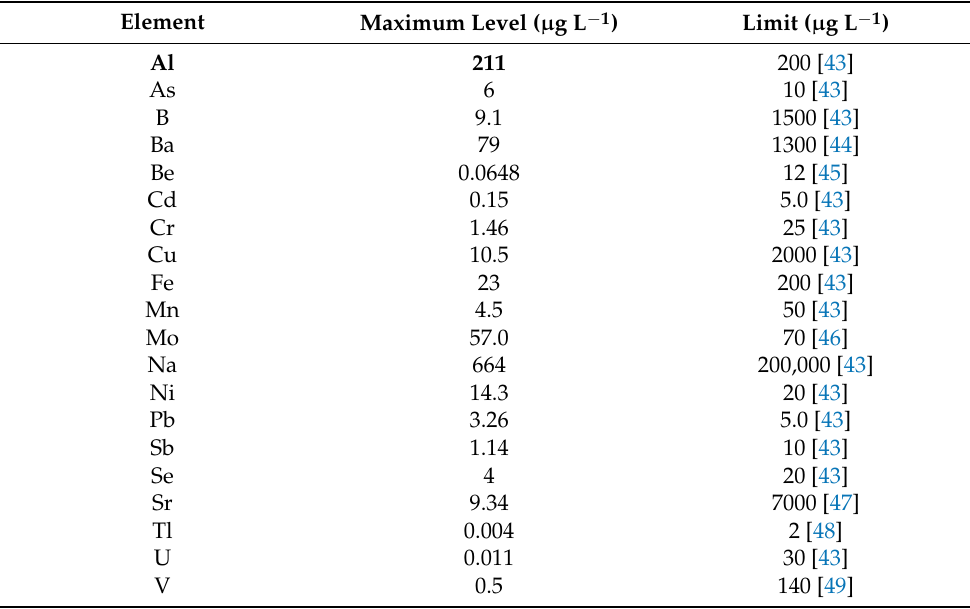
Table 5. Maximum levels found for each element in water samples stored in reusable water bottles and regulatory limits fixed by current legislation, both expressed in µ g L − 1